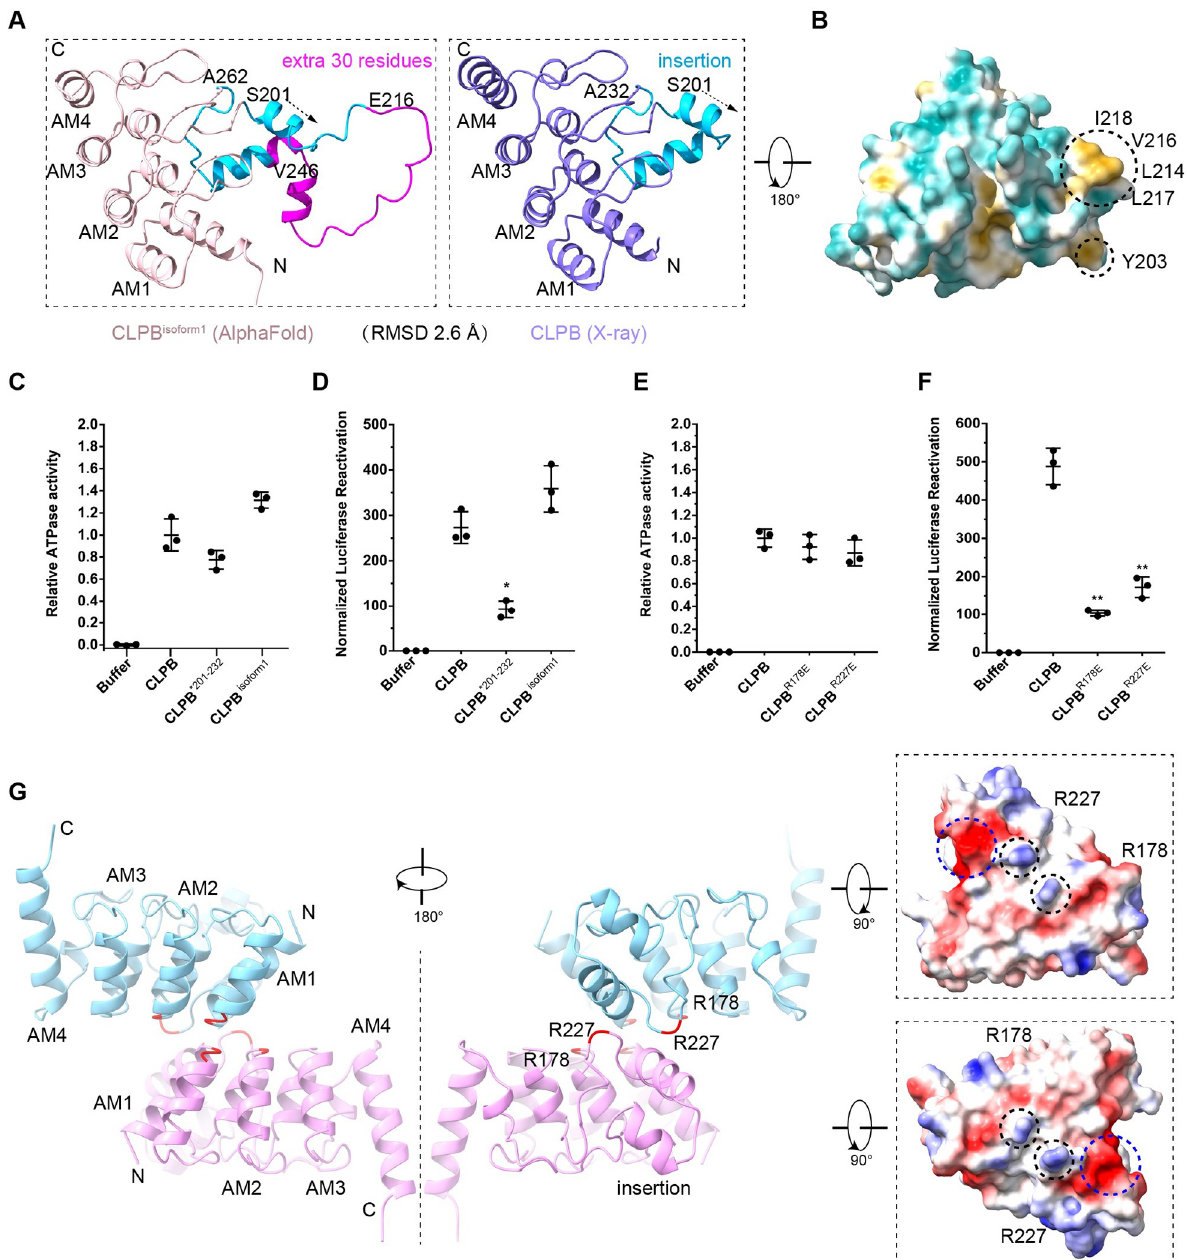
Fig 3. The ANK domain is essential for the disaggregase activity of CLPB. ( A ) X-ray crystallography structure and AlphaFold predicted model of the ANK domain. The RMSD between these 2 structures is 2.6 Å . ( B ) The hydrophobic surfaces of the ANK domain. Two hydrophobic patches were found in the unique insertion. ( C ) The ATPase assay of CLPB, CLPB Δ 201–232 , and CLPB isoform1 . ATPase activity was compared to CLPB ( N = 3, individual data points shown as dots, bars show mean ± SD) (S4 Data). ( D ) The disaggregase activity assay of CLPB, CLPB Δ 201–232 , and CLPB isoform1 . Disaggregase activity was compared to CLPB ( N = 3, individual data points shown as dots, bars show mean ± SD, � p < 0.05) (S4 Data). ( E ) ATPase assay of CLPB, CLPB R178E , and CLPB R227E (S4 Data). ( F ) Disaggregase activity assay of CLPB, CLPB R178E , and CLPB R227E . Results show that the disaggregase activities of CLPB R178E and CLPB R227E are reduced by 70%–80% ( N = 3, individual data points shown as dots, bars show mean ± SD, �� p < 0.01) (S4 Data). ( G ) The ANK domain dimer interface. One is the AM1-AM2 and the other is the second helix of the insertion. Two positively charged residues (R178 and R227) are labeled as black dashed circles on the ANK surface electrostatic potential.